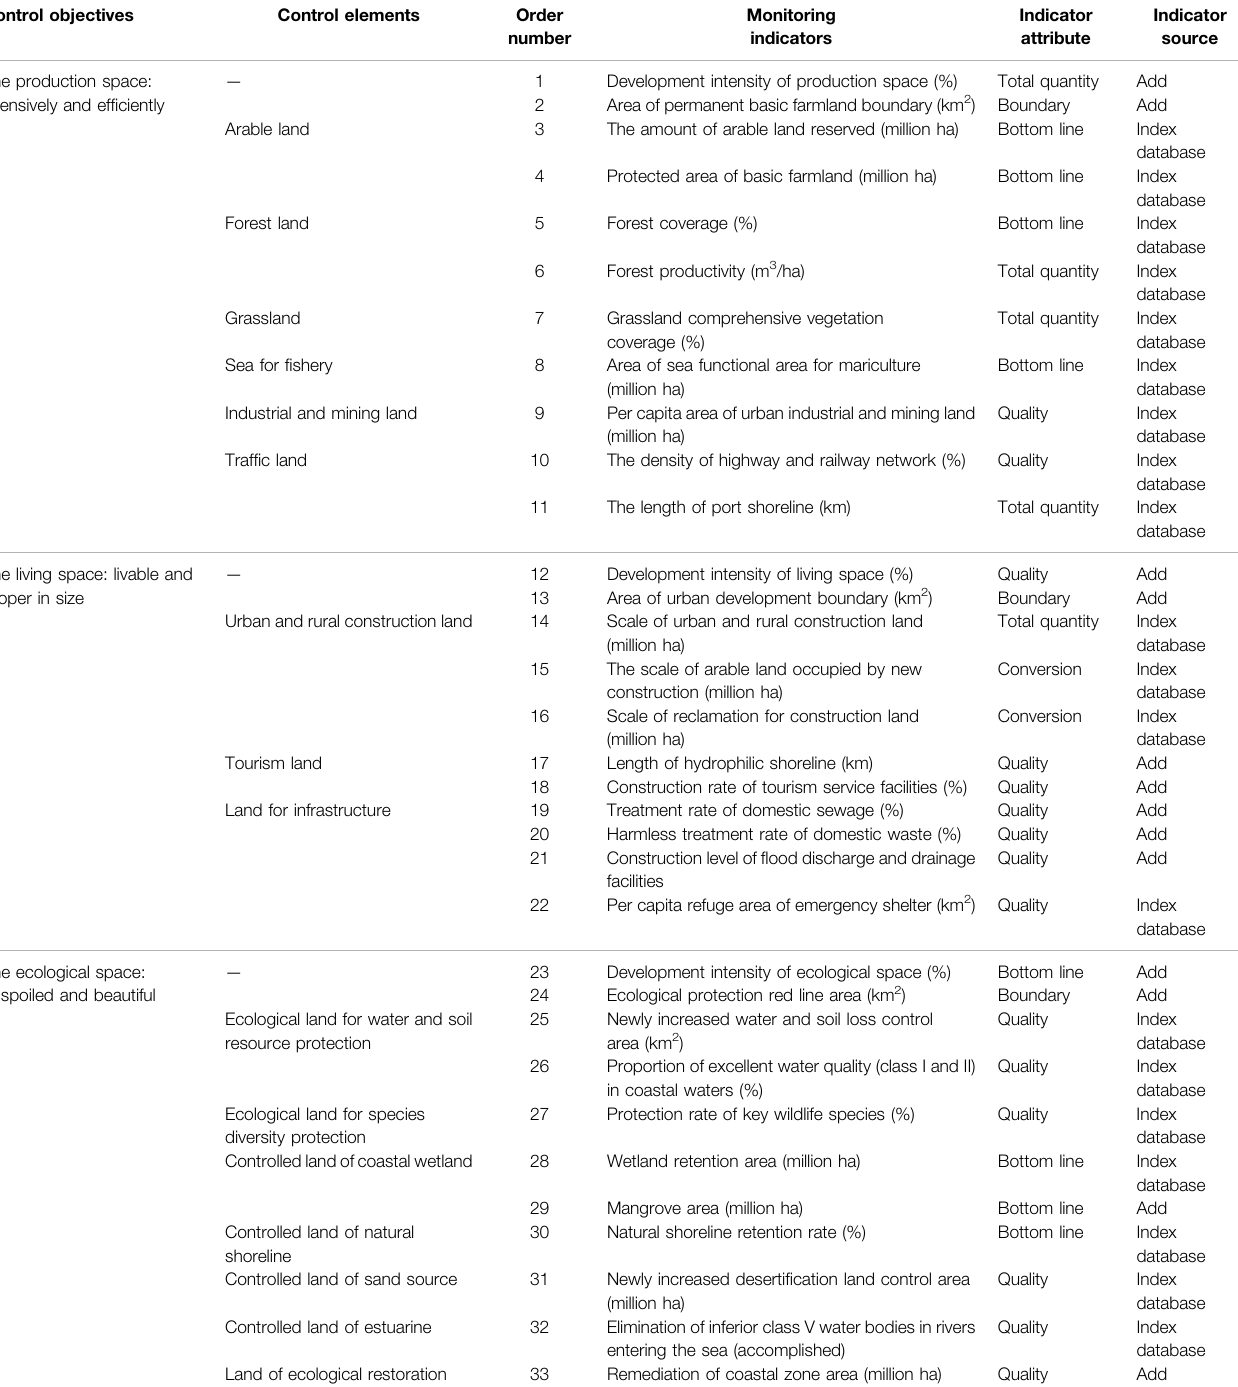
TABLE 2 | Construction results of the coastal zone spatial planning monitoring index